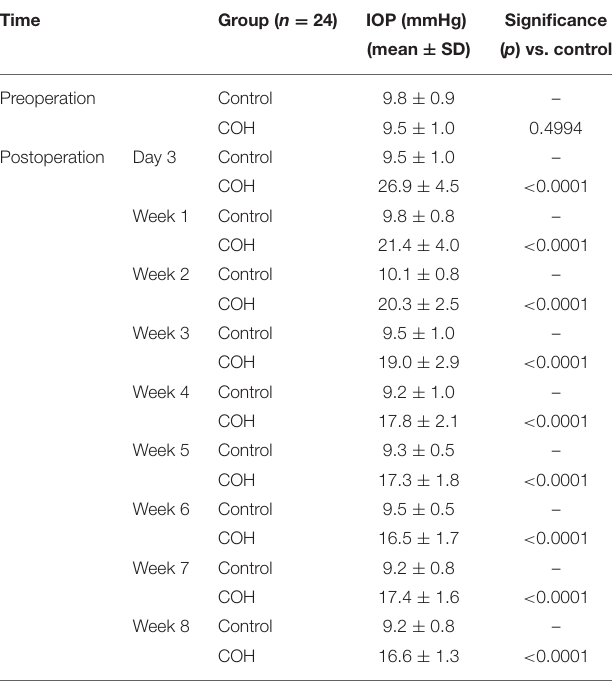
The 24 mice include 6 mice of the control group and 18 mice of the COH group. Data were analyzed using two-tailed independent-samples t test followed by Bonferroni test.